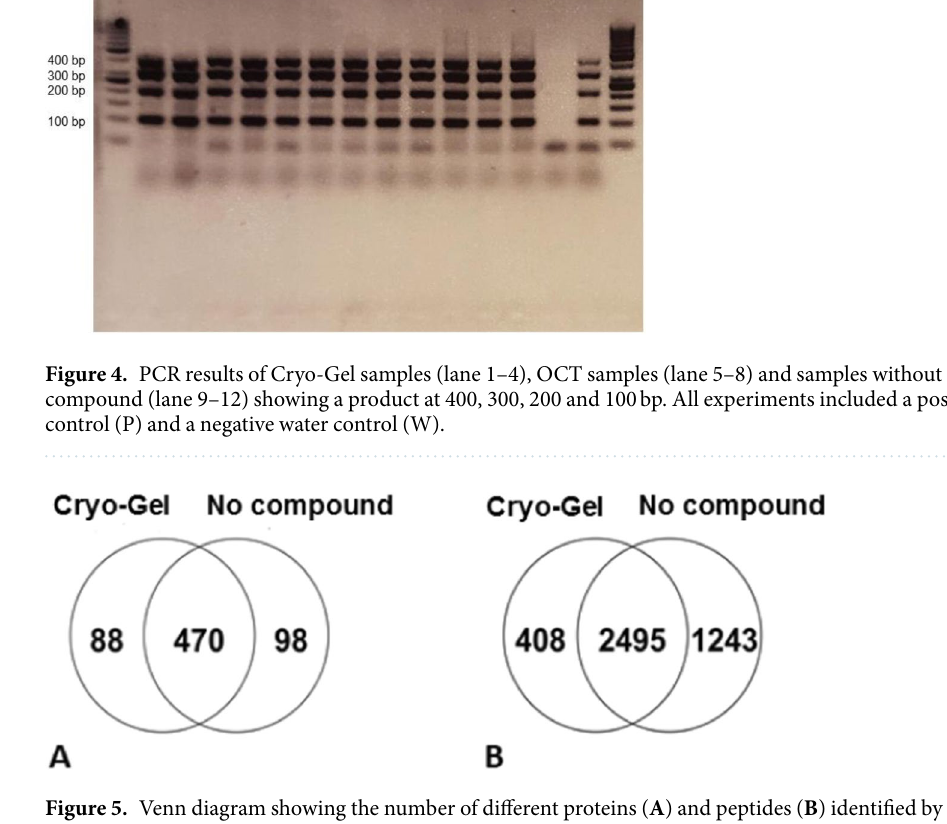
Figure 5. Venn diagram showing the number of different proteins ( A ) and peptides ( B ) identified by mass spectrometry and overlap between the samples embedded with Cryo-Gel and without